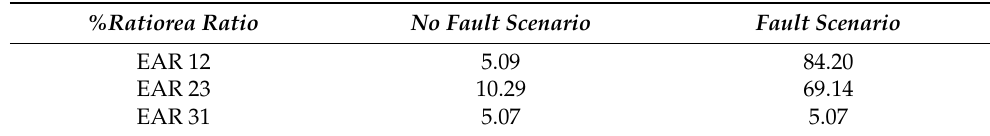
Table 2. Error area ratio index results.